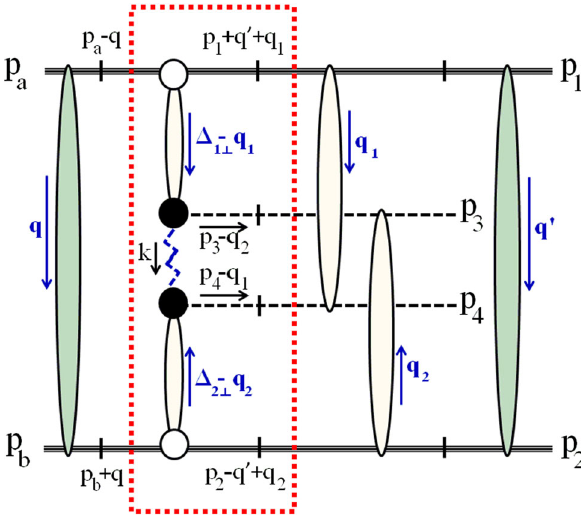
Fig. 12 Total amplitude of the process of double-pion LM CEDP p + p → p + π + + π − + p with detailed kinematics. Proton–proton rescatterings in the initial and final states are depicted as black filled circles,andpion–proton subamplitudes areshown as shadedcircles.All momenta are shown. The basic part of the amplitude, M 0 (see Eq. (5)), without corrections is circled by a dotted line. Crossed lines are on the mass shell. Here, Δ 1 ⊥ = Δ 1 − q − q (cid:3) , Δ 2 ⊥ = Δ 2 + q + q (cid:3) , ˆ t = k 2 =